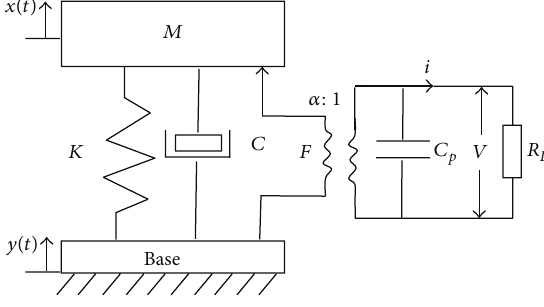
Figure 2: Coupled LPM of the